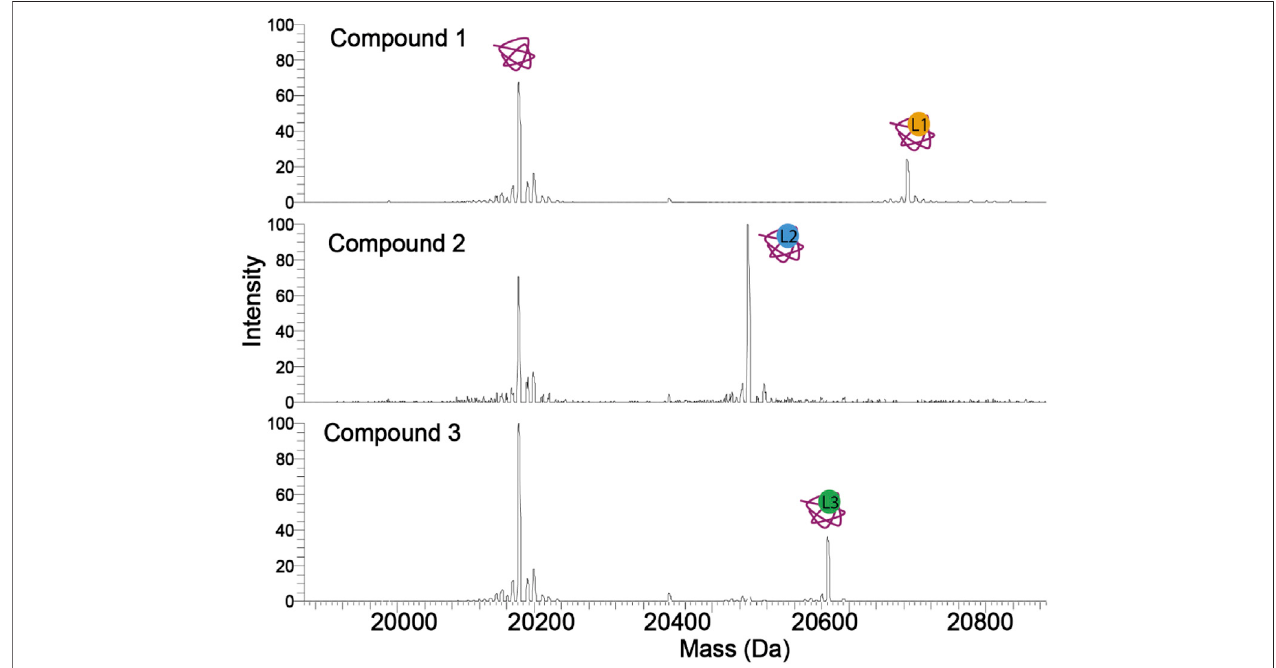
FIGURE2| Spectraofaproteinincomplexwiththreecompounds(ligands).Thetighterbindingcompoundyieldsamoreintensecomplexpeak.Therefore,without calculating the K d , the af fi nity of a compound against a protein can be estimated. Compound 2 has the highest occupancy to the protein, followed by compounds 3 and